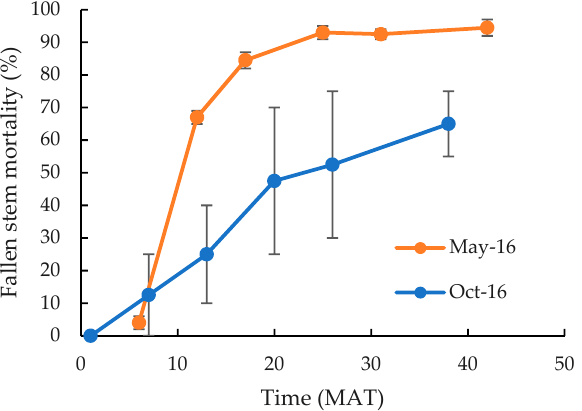
Figure 2. Mortality for C. uruguayanus fallen stems in response to cut stump herbicide application in May (orange) or October (blue) 2016 (Experiment 1). Vertical bars represent the standard error of the mean.